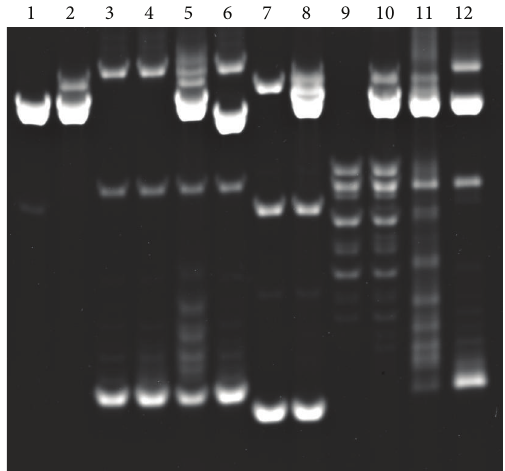
Figure 2: R-loop formation in trans and its dependence on super- coiling of the target DNA. RNA containing an AGGAG repeat was produced from linearized pSK-(AGGAG) 22 , and the effects on a T7 promoterless plasmid containing an AGGAG repeat, pHC624-(AGGAG) 22 , were examined by agarose gel electrophore- sis. Lane 1: pSK-(AGGAG) 22 linearized with Xba I; lane 2: linearized pSK-(AGGAG) 22 transcribed with T7 RNA polymerase; lane 3: supercoiled pHC624-(AGGAG) 22 , which lacked T7 promoter; lane 4: supercoiled pHC624-(AGGAG) 22 incubated in transcription mixture with T7 RNA polymerase; lane 5: supercoiled pHC624- (AGGAG) 22 and linearized pSK-(AGGAG) 22 transcribed with T7 RNA polymerase; lane 6: supercoiled pHC624-(AGGAG) 22 and pBluescript SK (−) linearized with Xba I, transcribed with T7 RNA polymerase; lane 7: supercoiled pHC624; lane 8: supercoiled pHC624 and linearized pSK-(AGGAG) 22 incubated in transcription mixture with T7 RNA polymerase; lane 9: pHC624-(AGGAG) 22 relaxed with vaccinia topoisomerase I; lane 10: relaxed pHC624- (AGAAG) 22 and linearized pSK-(AGGAG) 22 transcribed with T7 RNA polymerase; lane 11: same as lane 5 and ethanol-precipitated; lane 12: same as lane 11 and treated with 90 units of E. coli RNase H (TaKaRa) in 40 mM Tris ⋅ HCl pH 7.7, 4mM MgCl 2 , 1mM DTT, 4% glycerol, and 0.003% bovine serum albumin at 37 ∘ C for